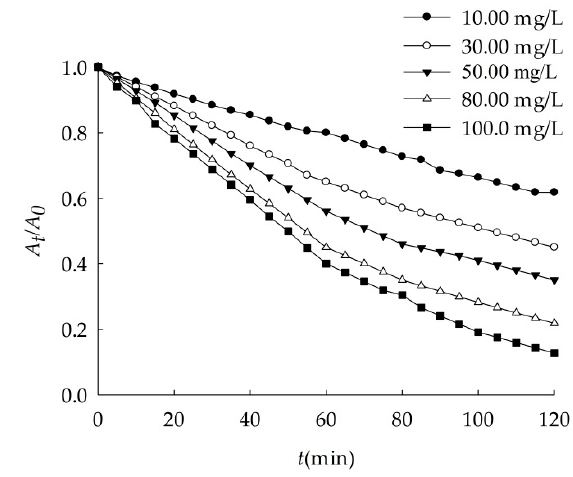
Figure 6. Effects of concentration on the sedimentation of nano-Al 2 O 3 ( S = 31.5, pH = 8.00). Table 8. Dynamics fitting of nano-Al 2 O 3 sedimentation with different concentration in ASW. C (Al 2 O 3 , mg/L) k ( min − 1 ) r